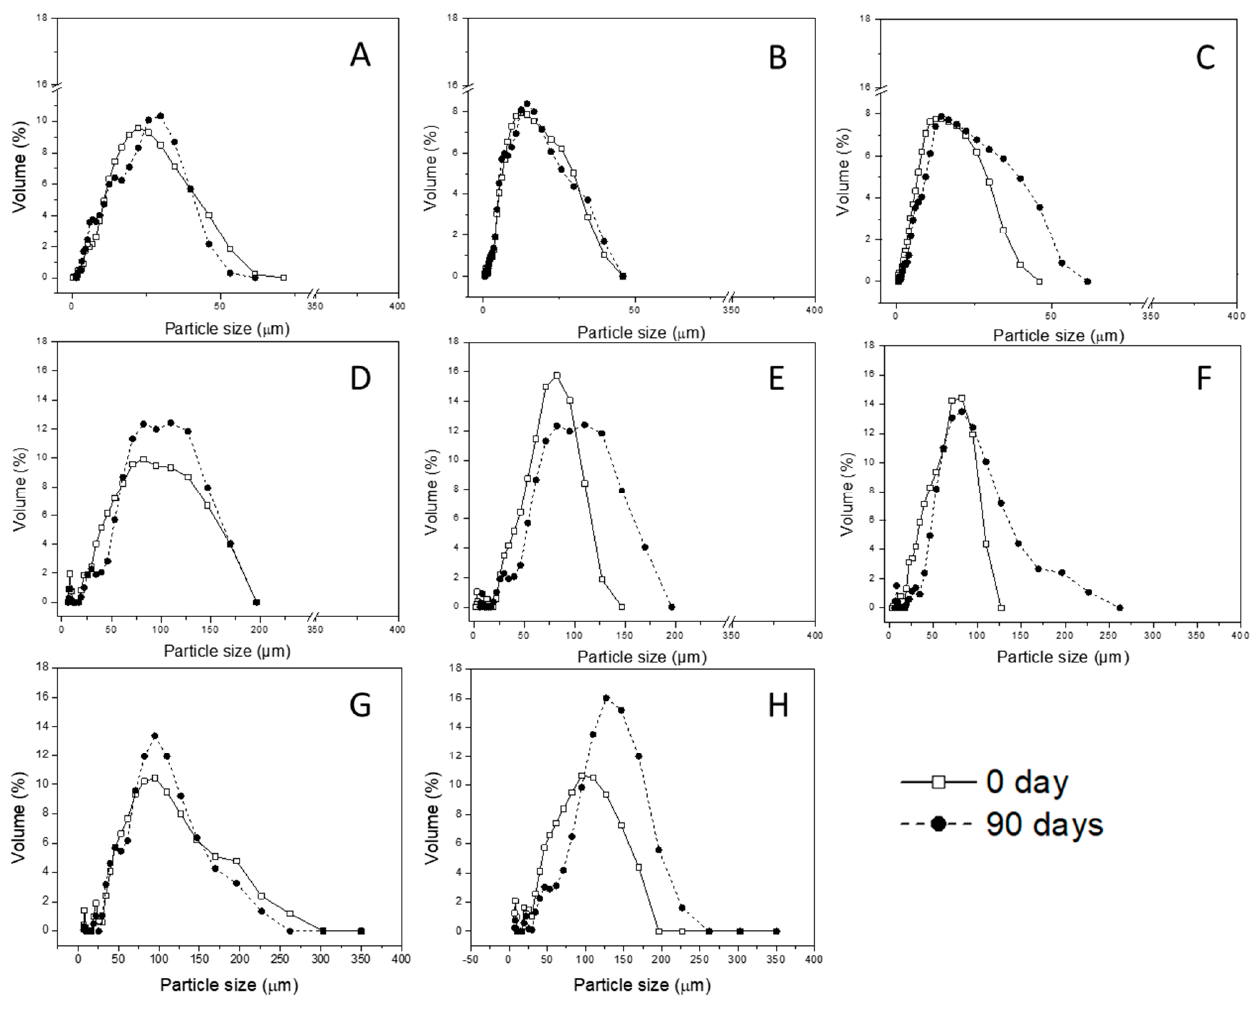
Figure 1. Particle size distribution of microparticles prepared by spray drying, chilling, and the combined process: ( A – C ) microparticles obtained by spray drying with a 20%, 25%, and 33% ratio core/carrier material, respectively; ( D – F ) microparticles obtained by spray chilling with a 20%, 30%, and 40% ratio core/carrier material, respectively; ( G , H ) microparticles obtained by spray drying and chilling combination with a 10% and 20% ratio core/carrier material, respectively.